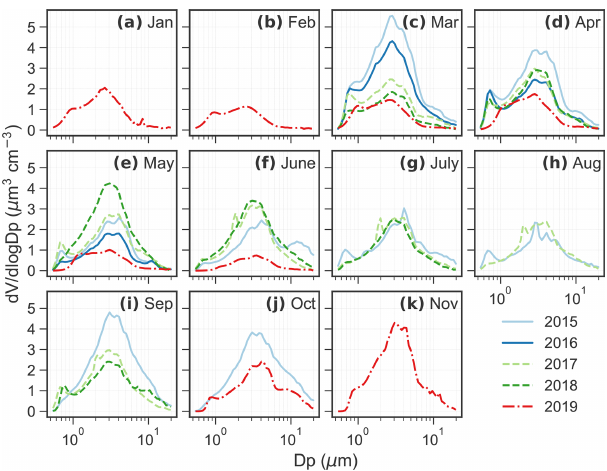
Figure 1. Monthly average aerosol volume size distribution from 2015 to 2019. There are missing data in some months but good data coverage from March to June. No data are available in December. Monthly average aerosol number size distribution measured by the APS during 2015–2019 is shown in Fig.